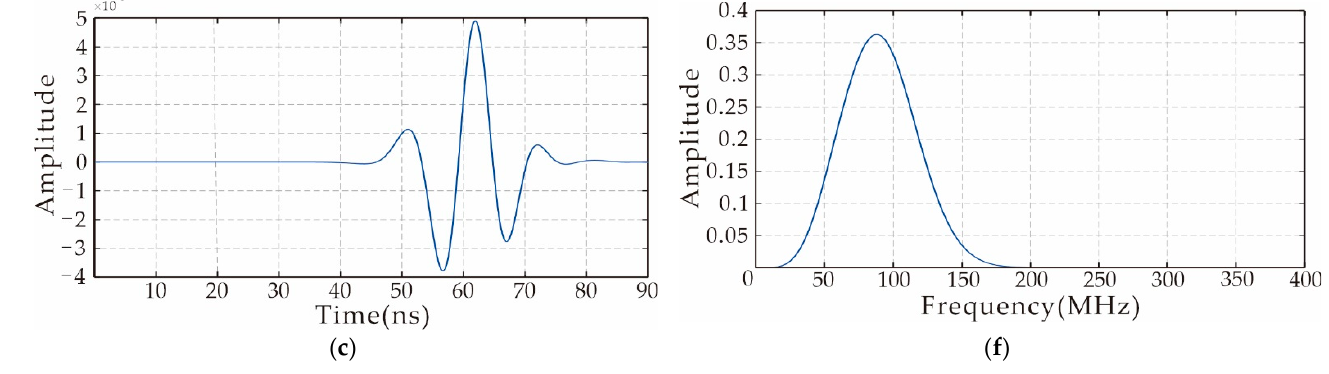
Figure 1. Convolutional spectrum analysis. ( a ) Source wavelet of real data: center frequency 100 MH and corresponding ( d ) spectrum; ( b ) source wavelet used in the forward modeling: center frequency 60 MHz and corresponding ( e ) spectrum; ( c ) a residual field source and the corresponding ( f ) spectrum.